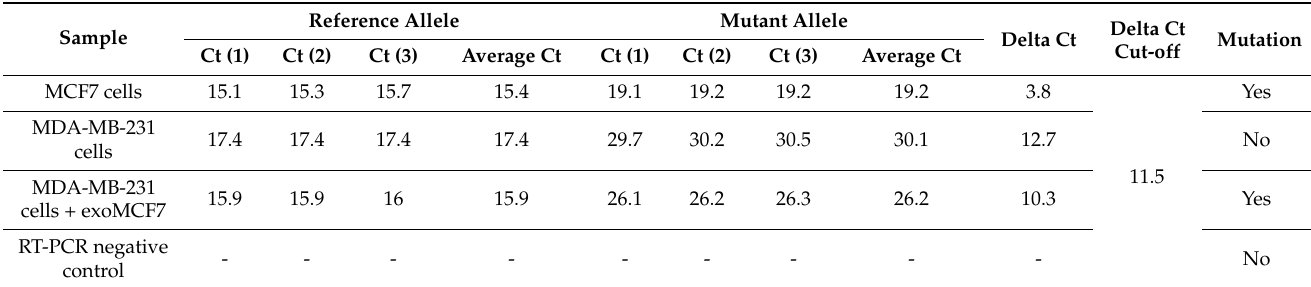
Table 1. Allele-specific real-time PCR of the DNA samples of exosome-treated cells. Reference Sample